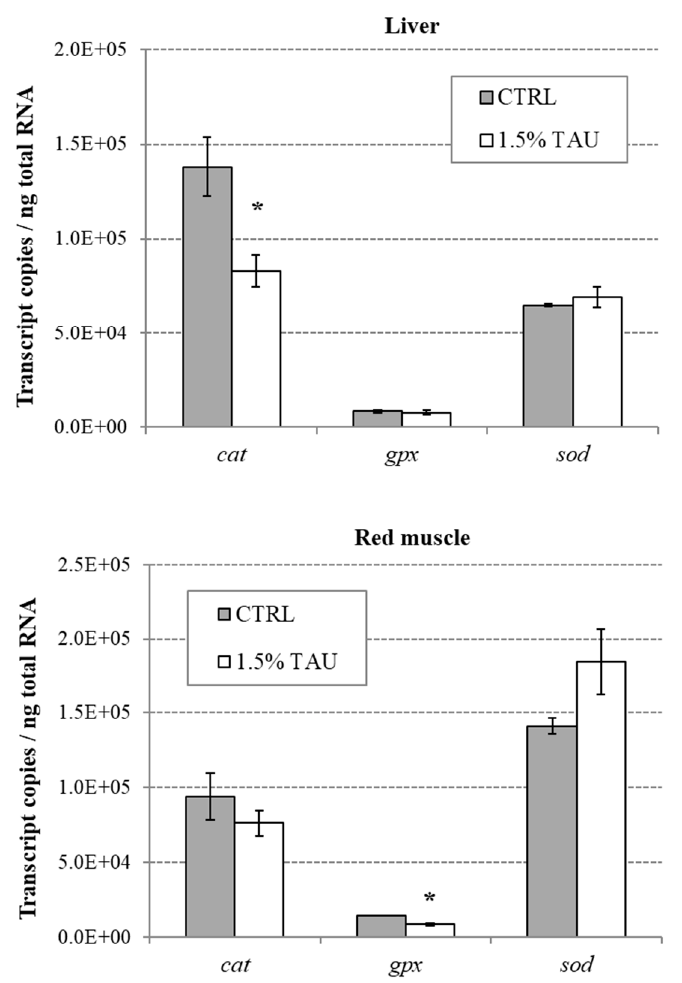
Figure 3. Absolute quantification of transcript copies of cat, sod , and gpx genes in liver and red muscle of European seabass fed with the control or with the 1.5% Tau-supplemented diet (mean ± SEM, n = 5 fish/diet). (*) means significant differences between dietary groups ( p < 0.05).